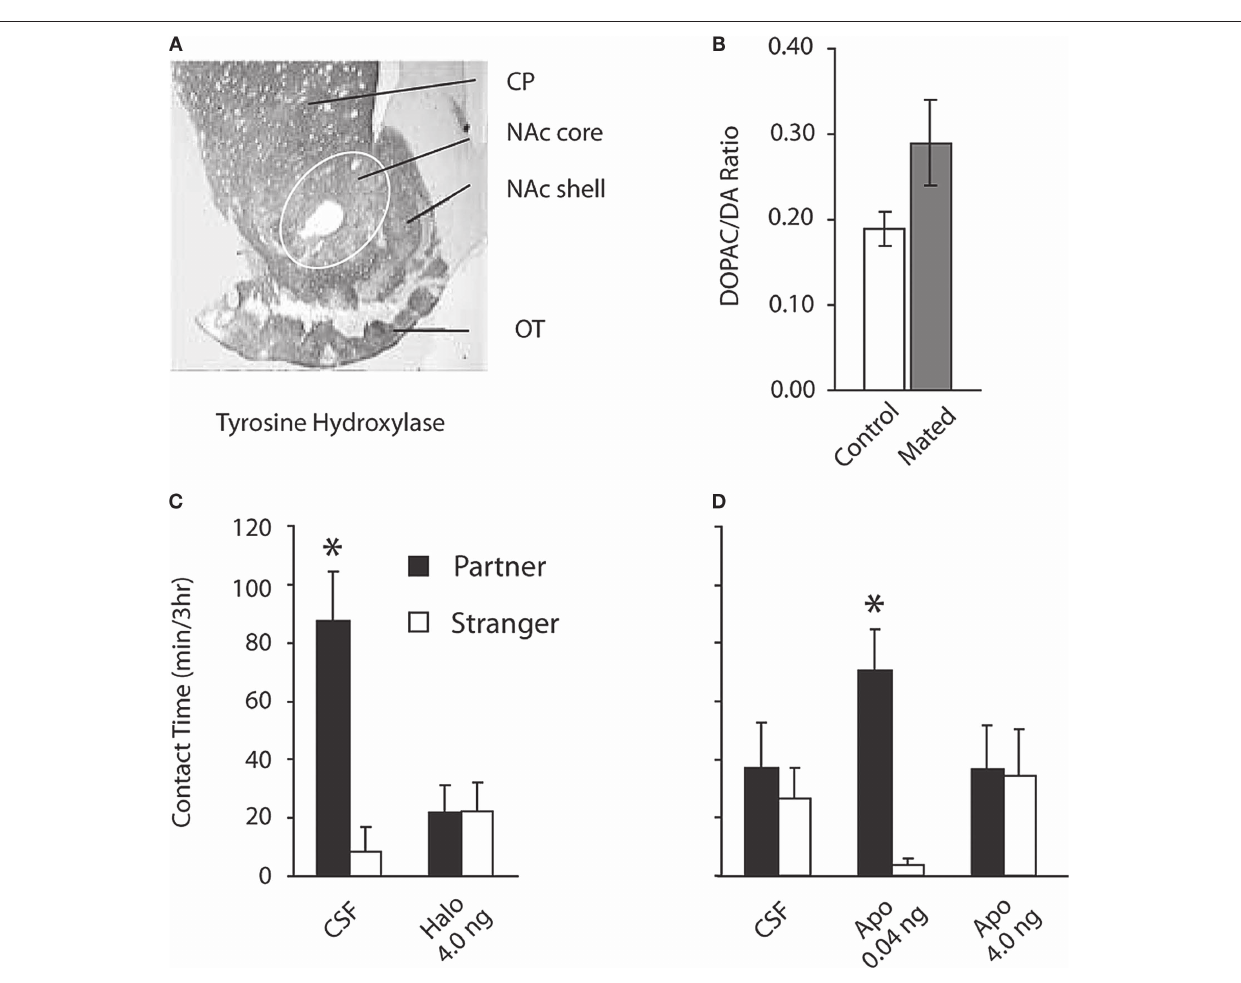
chemical extraction, and measurement using HPLC-ED. Male prairie voles show increased mean DA turnover 30 min after mating onset with an estrogen-primed female. (C) Blockade of DA receptors within the NAc by micro-infusion of haloperidol (Halo) prevented mating-induced partner preference formation. (D) Micro-infusion of low (0.04 ng) but not high (4.0 ng) dose of apomorphine (Apo) induced partner preferences in the absence of